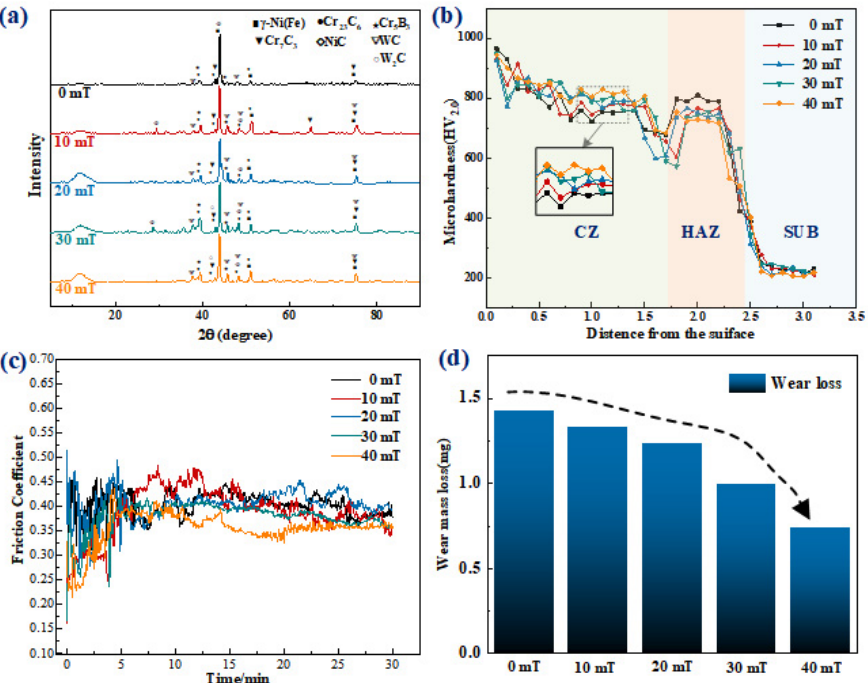
Figure 4. SEM images of middle regions of coatings and element composition at different points on the surface of coatings.